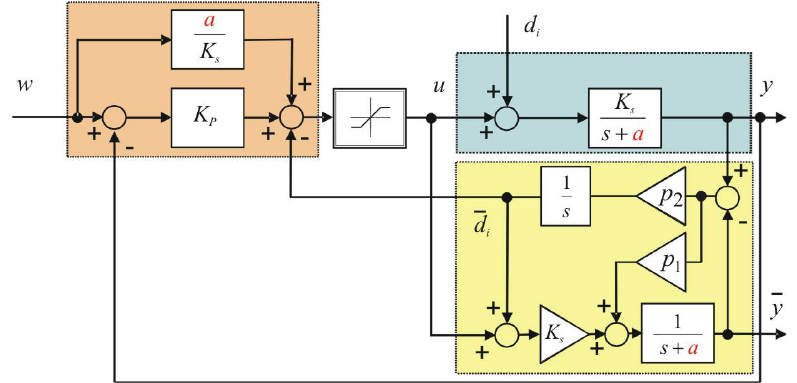
Figure 9. Closed control loop: P controller with static feed forward (orange), extended state observer (yellow), controlled plant (blue).